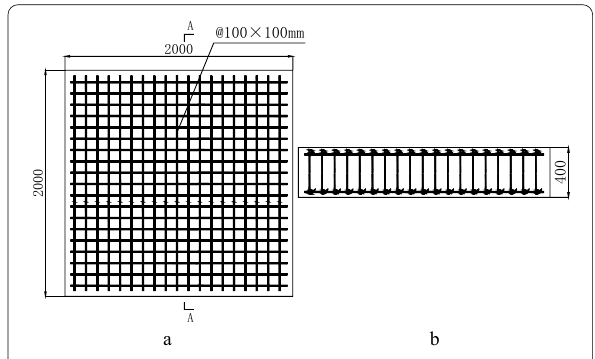
Fig. 6 The reinforcement of the steel-fiber reinforced concrete slab: a front view of slab. b Sectional view of A–A.